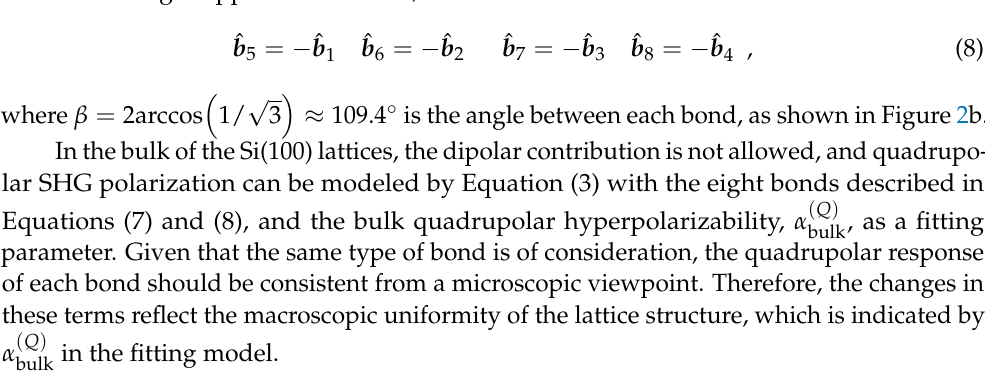
where 𝛽 = 2 arccos(cid:3435)1/√3(cid:3439) (cid:3406) 109.4° is the angle between each bond, as shown in Figure